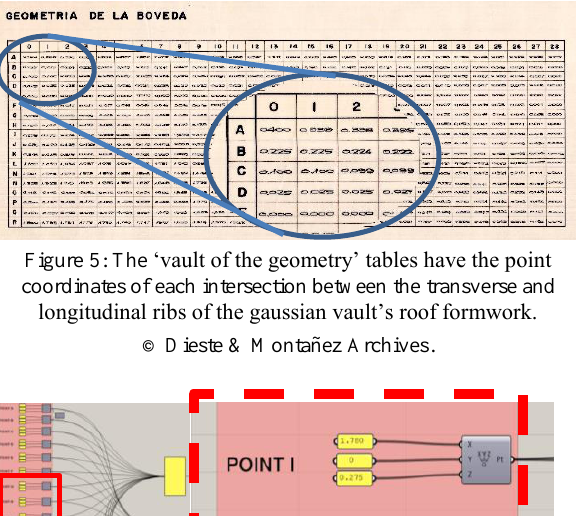
Figure 7: (a.) Algorithm developed in Grasshopper© in association with Rhinoceros 3d 6.0©, which gathers the complete set of point coordinates from Figure 5, and the corresponding surface generated in the Rhinoceros display (b.).